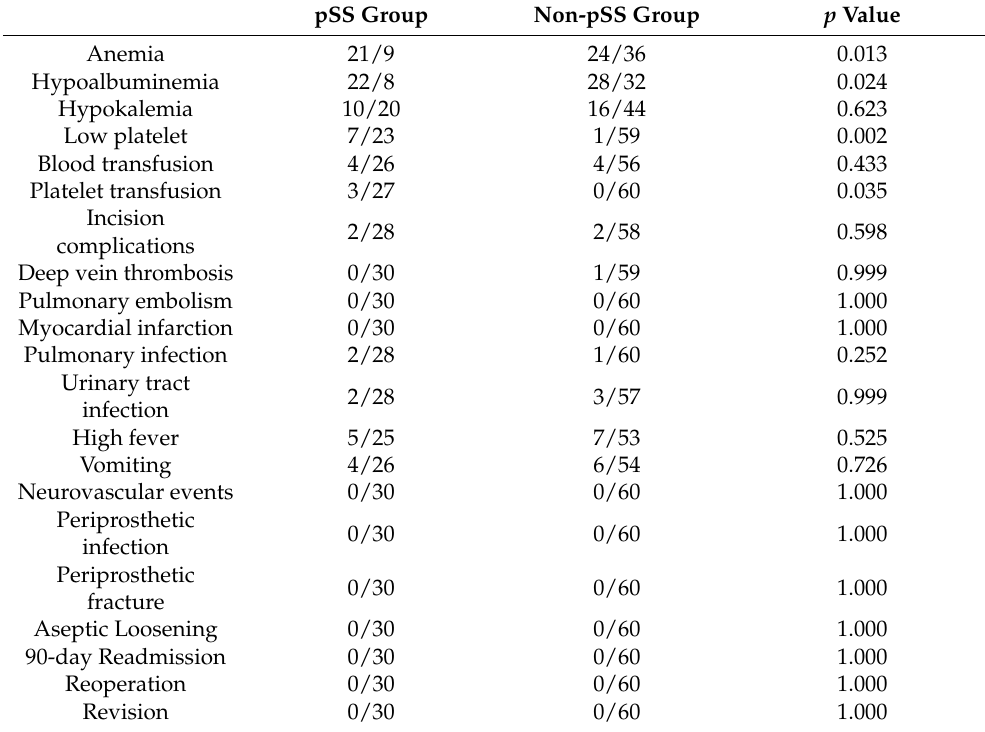
Table 5. Postoperative complications.